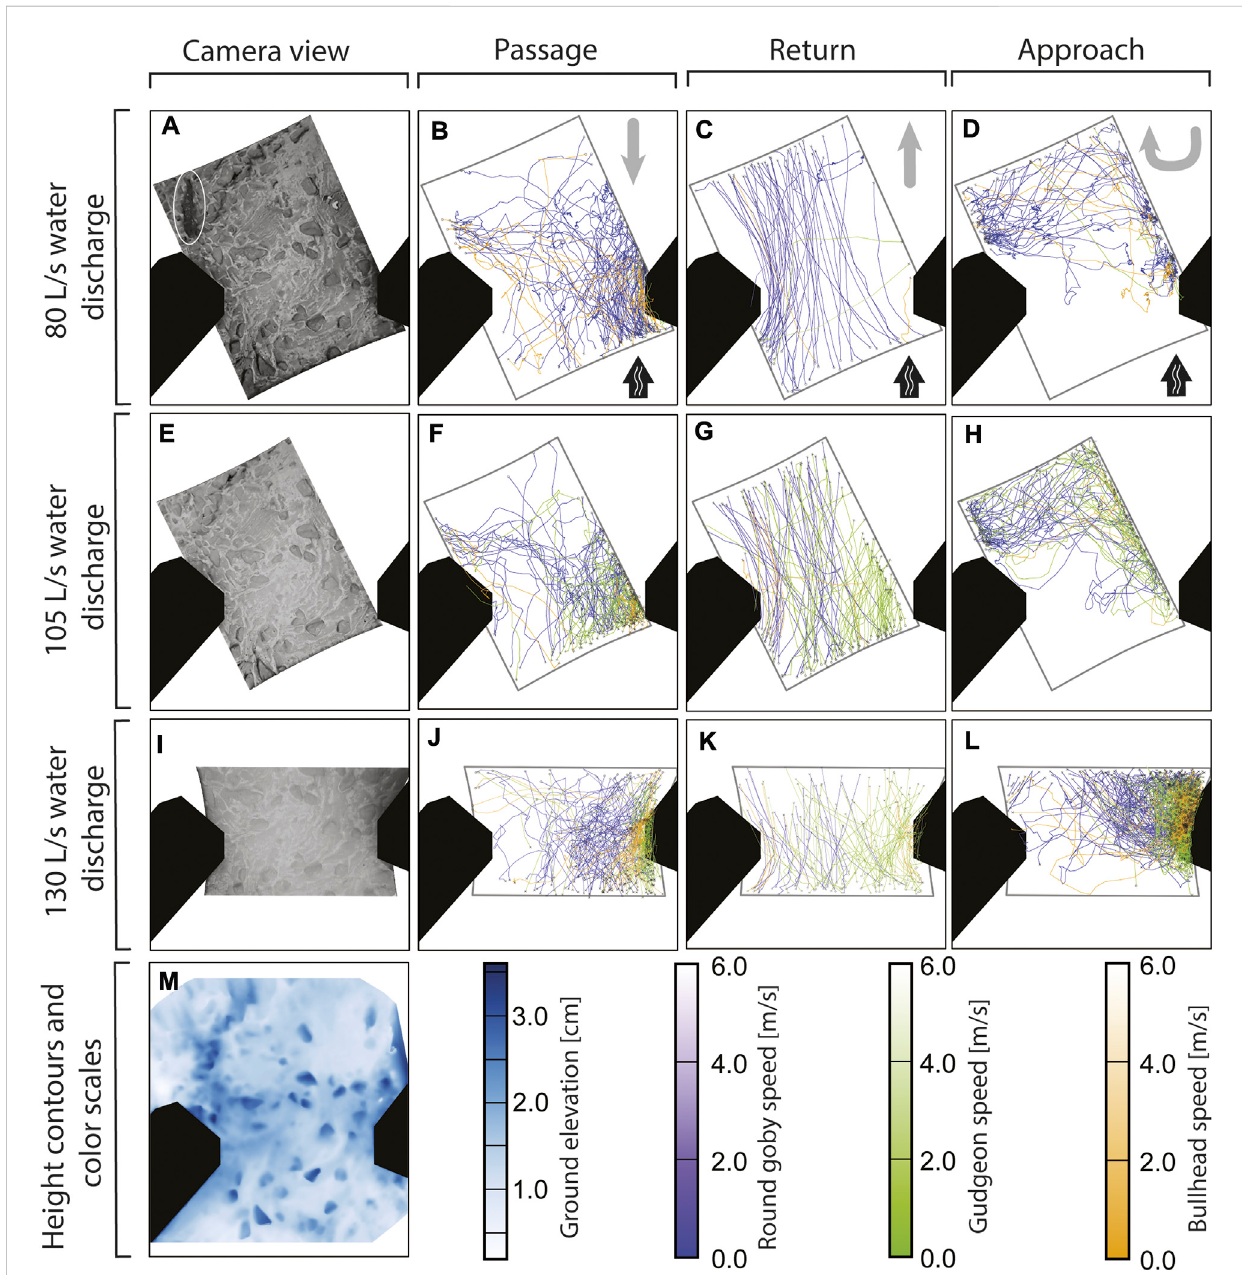
FIGURE 4 Fish trajectories of round goby, gudgeon, and bullhead recorded with a camera above a vertical slot at different water discharges (B – D,F – H,J – L) . The swimming direction for the corresponding event (passage, return, or approach) is provided in (B – D) by grey arrows in the upper right corner, with black arrows indicating the water fl ow direction. The camera view is provided at the left side (A,E,I) with one round goby displayed (white ellipse in A). Ground elevation in the vertical slot area (M) was determined using triangulation of 70 camera images of the slot